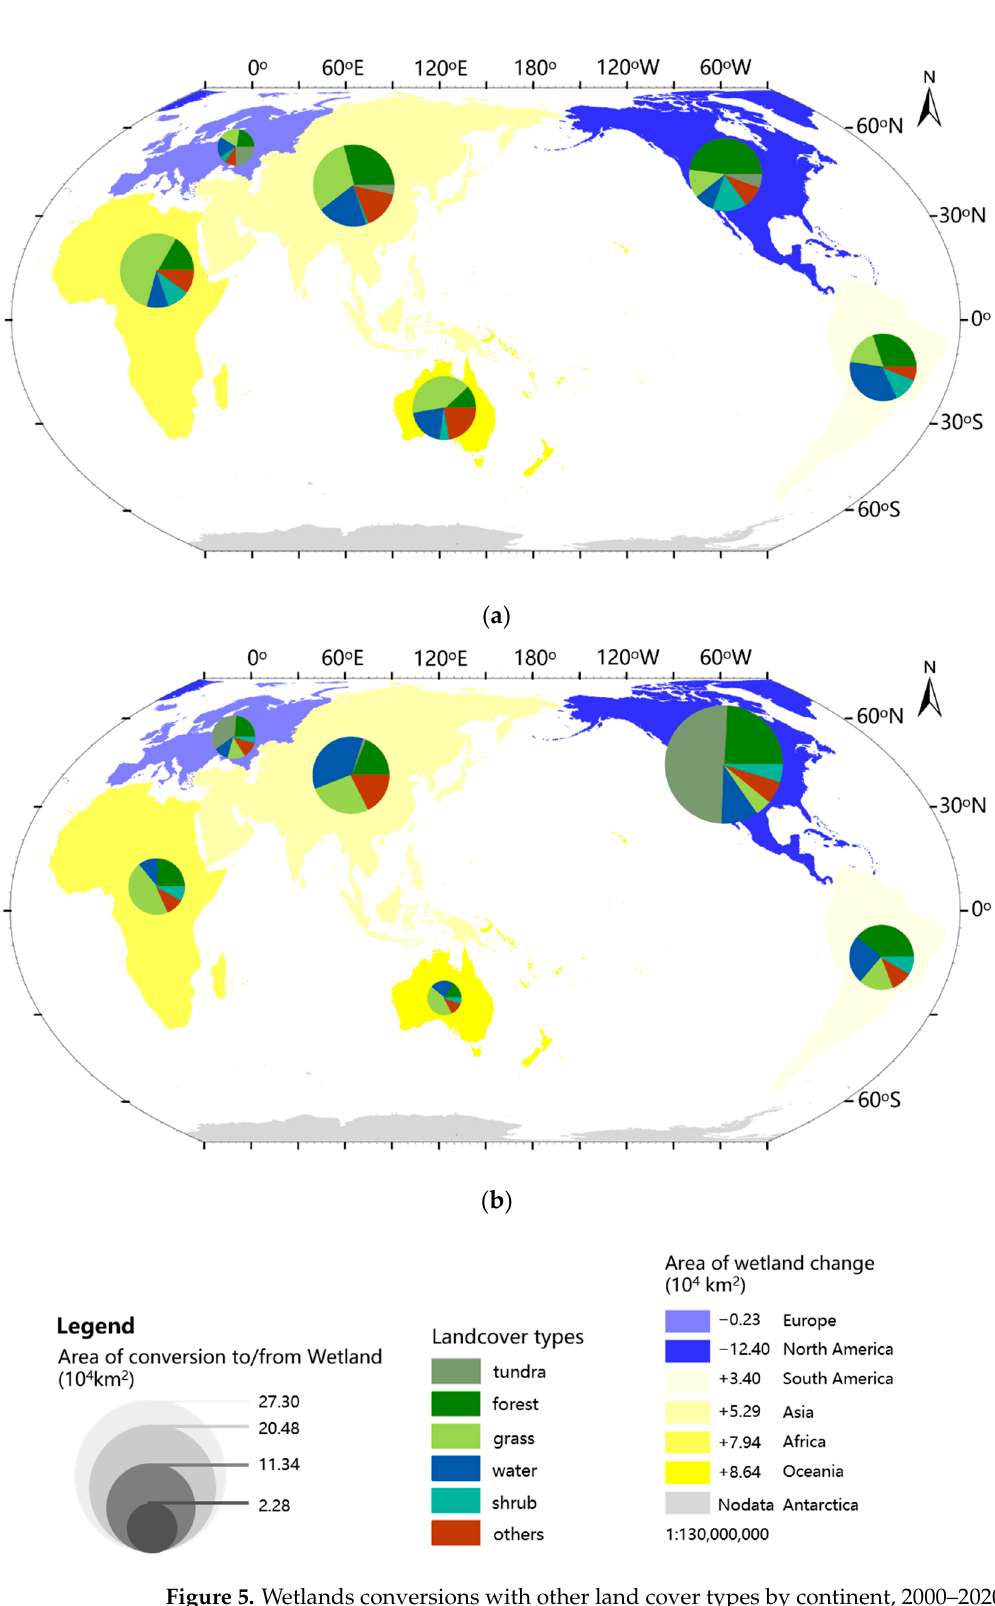
Figure 5. Wetlands conversions with other land cover types by continent, 2000–2020. ( a ). Wetlands converted from other land cover types by continent, 2000–2020. ( b ) . Wetlands converted to other land cover types by continent, 2000–2020.